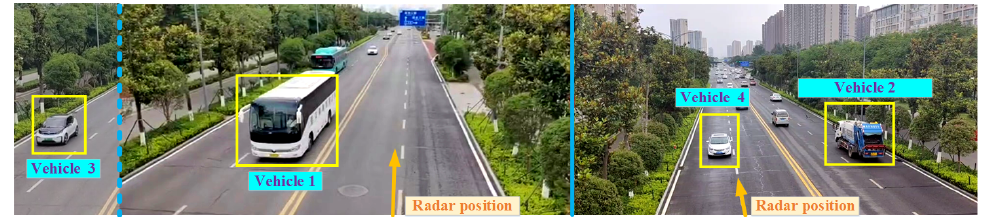
Figure 21. Driving vehicle imaging examples.